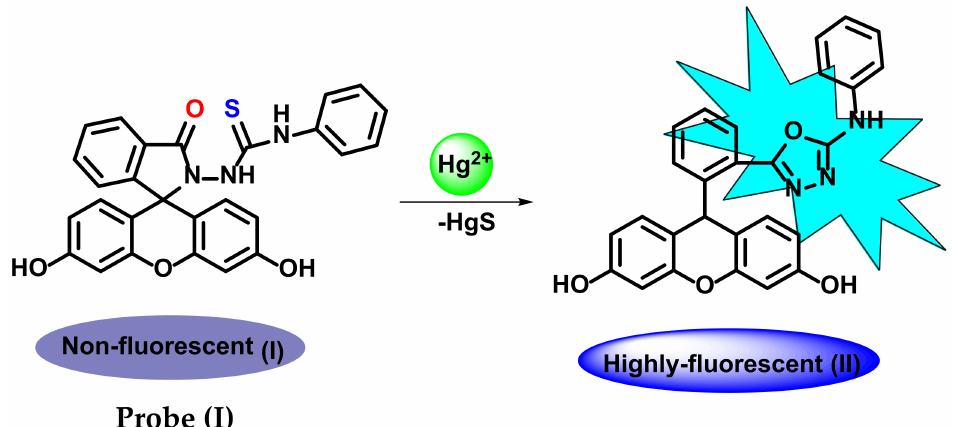
Figure 8. Desulphurization of I by Hg 2+ ion, leading to the highly fluorescent oxadiazole (II). Reproduced with permission from [23] by